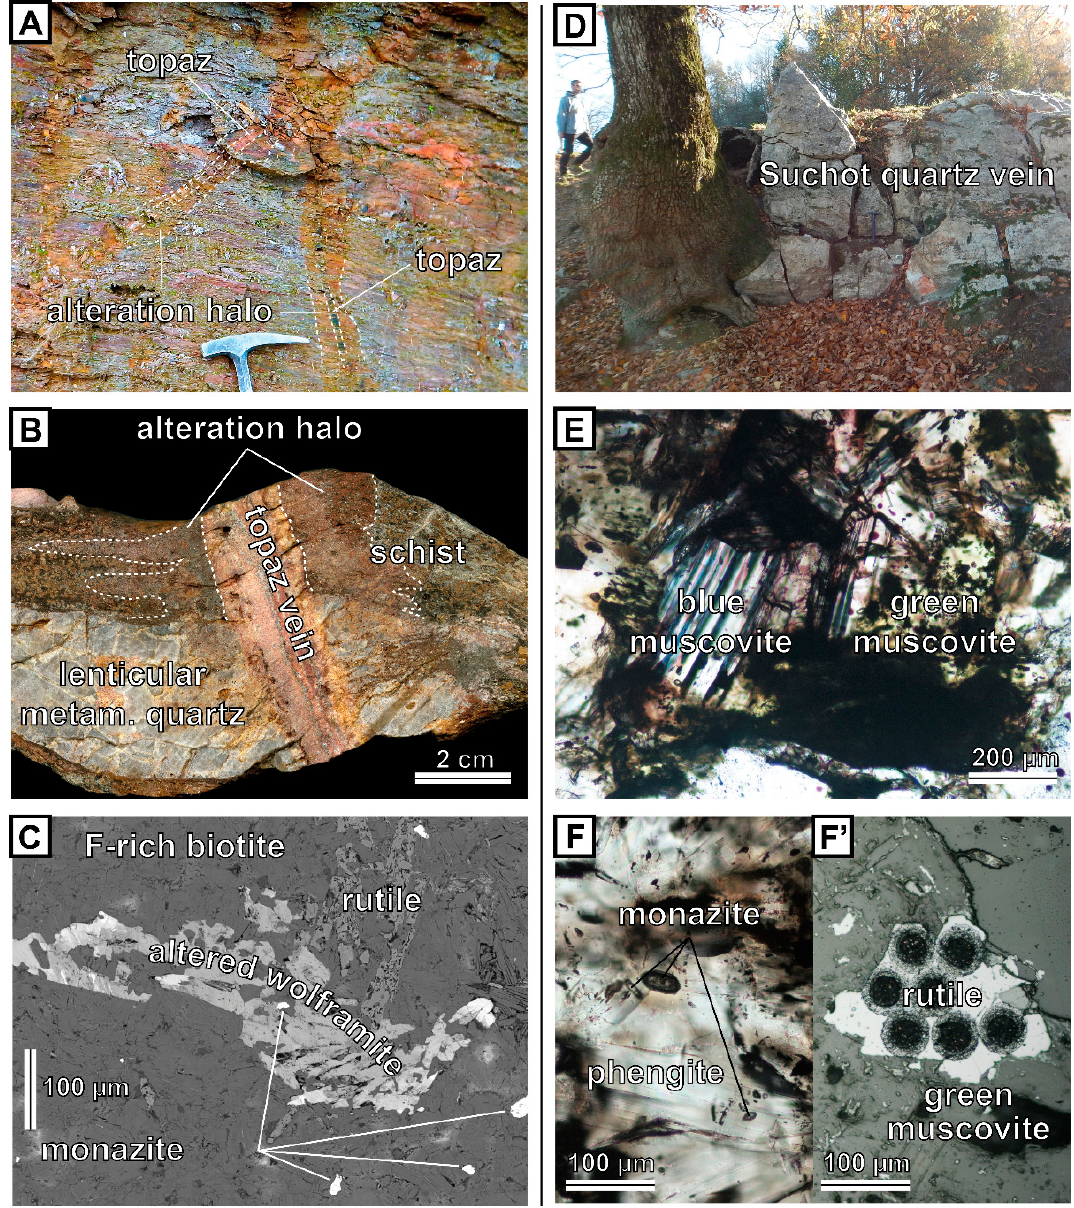
Figure 2. Alteration haloes and mineral textures from the topaz ( A – C ) and Suchot ( D – F ) veins. ( A ): Outcrop image of topaz veins and their alteration halos. Colors are saturated for better clarity. ( B ): Photograph of topaz vein sample crosscutting the metamorphic foliation. Alteration halo is well marked in the schist. ( C ): Backscattered electron image of altered wolframite b and associated monazite in the alteration halo of the topaz veins. Matrix of the alteration is mostly composed of F-rich brown micas ( D ): Outcrop photograph depicting the metric-sized Suchot vein. ( E ): In the selvage of the Suchot vein, metamorphic minerals are entirely replaced by hydrothermal quartz and two generations of micas: green and pale-blue colored muscovite crystals. Photomicrograph is in Plane-Polarized Light (PPL). ( F ): Blue muscovite crystals display numerous inclusions of monazite while rutile inclusions are lacking (PPL). ( F’ ): Reflected light image of rutile crystal included in green muscovite. Conversely to blue muscovite, monazite inclusion is scarce in this type of micas.